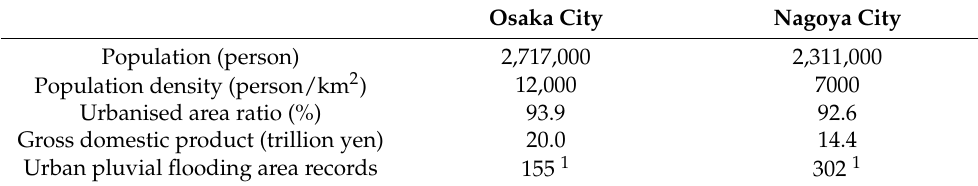
Figure 1. Location of the target cities in Japan and low-lying areas in the target cities. Low-lying areas are classified by the Ministry of Land, Infrastructure, Transport, and Tourism (MLIT) as areas where the elevation is lower than the surrounding [18]. Table 1. Detailed information on Osaka and Nagoya